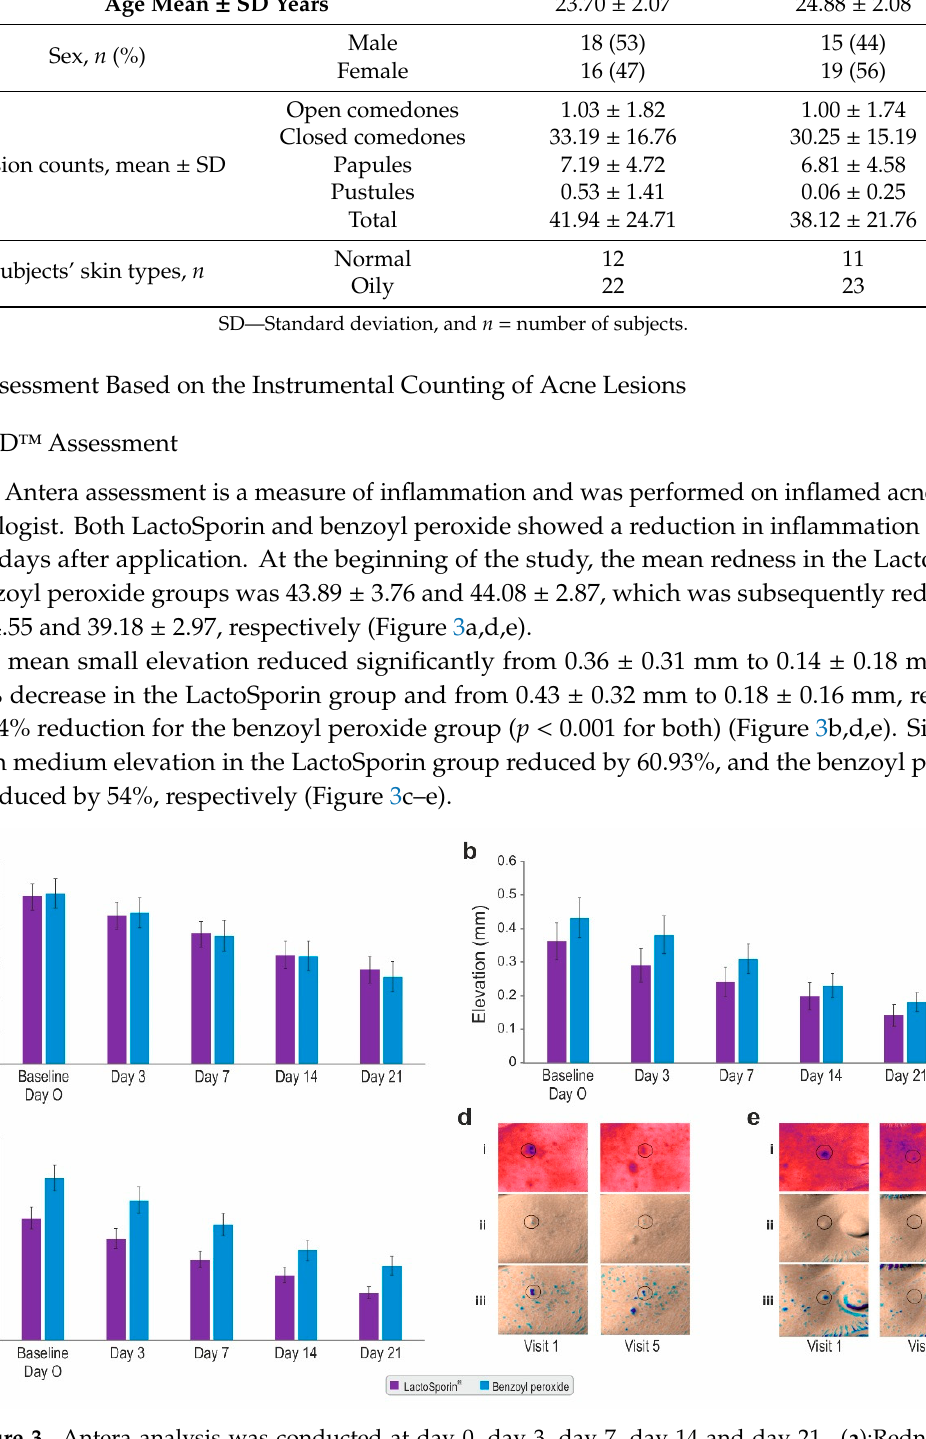
Figure 3. Antera analysis was conducted at day 0, day 3, day 7, day 14 and day 21. ( a ):Redness (Hb- index—% hemoglobin hyper-concentration) in the inflammatory response. ( b ) Elevation (small) in